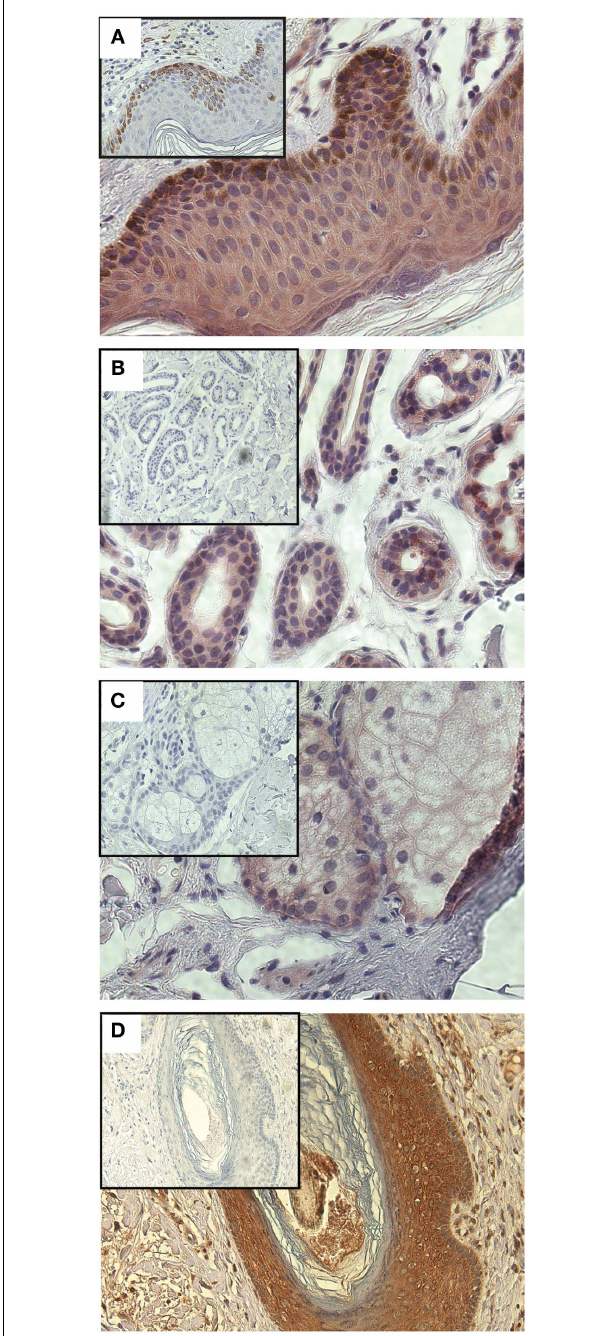
FIGURE 5 | Immunohistochemical staining of GLIPR1 in skin specimens . Immuno-reactive cells of normal skin (A) , sweat glands (B) , sebaceous glands, (C) , hair follicles (D) . Skin specimens (A–C) were stained with NovaRED to give a red color for GLIPR1 immuno-positive regions, while hair follicles (D) were stained with DAB to give brown color for GLIPR1. Cell nuclei are stained blue with hematoxylin. Inset images show negative control reacted with the non-specific goat serum instead of anti-GLIPR1 antibody. Lack of brown staining in the negative control indicates this is due to GLIPR1 and not melanin. All images were photographed at a power of 400 ×